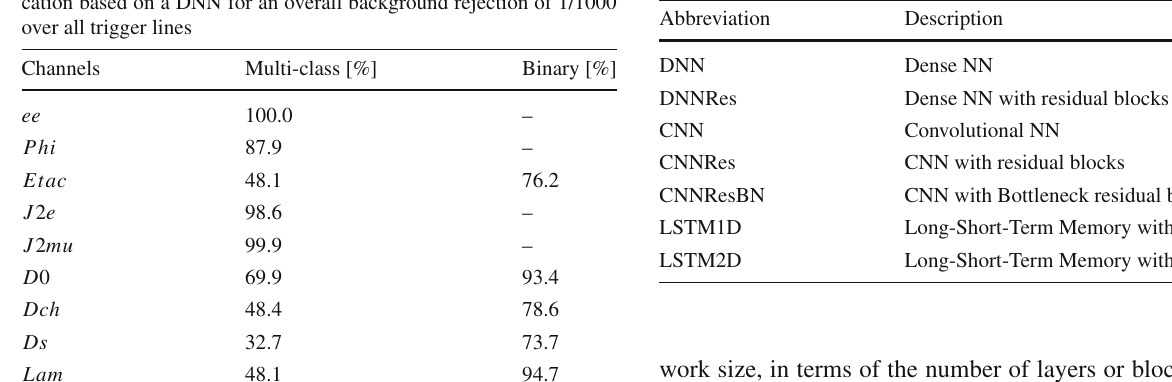
Table 5 The list and the description of the NNs investigated for the PANDA Software Trigger in this